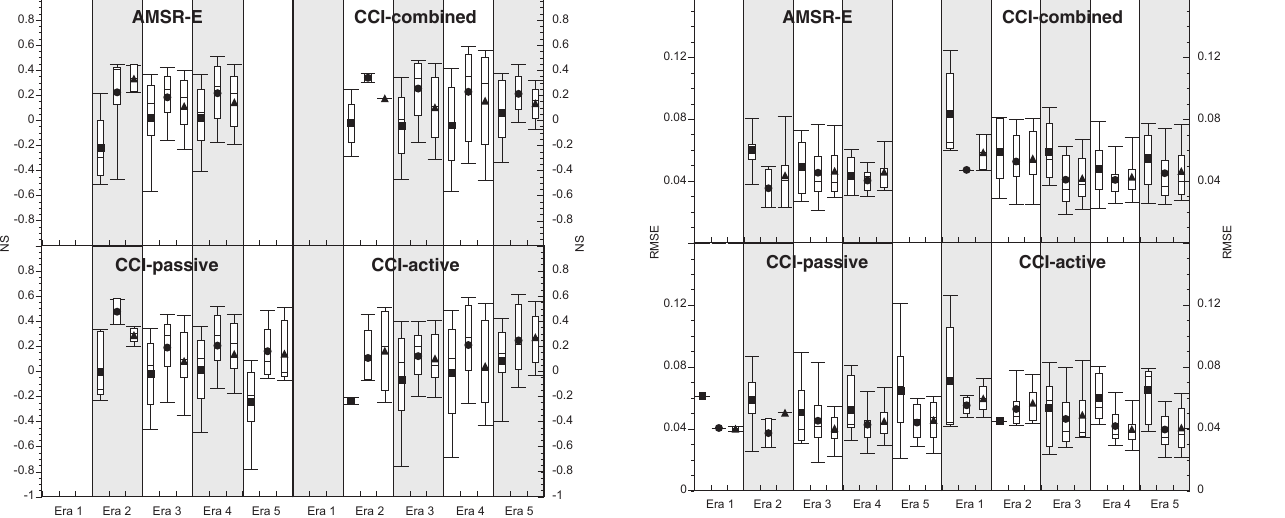
Figure 6. Box plots depicting the NS metric for the SNOTEL net- work. Symbols are the same as in Fig. 4.